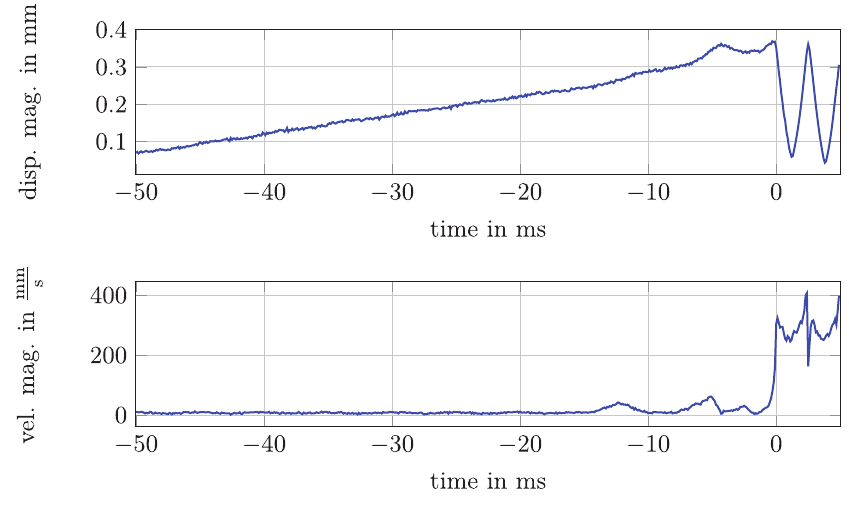
Figure 9. Magnitude of displacement (top) and magnitude of velocity (bottom) of the string measured close to the plucking